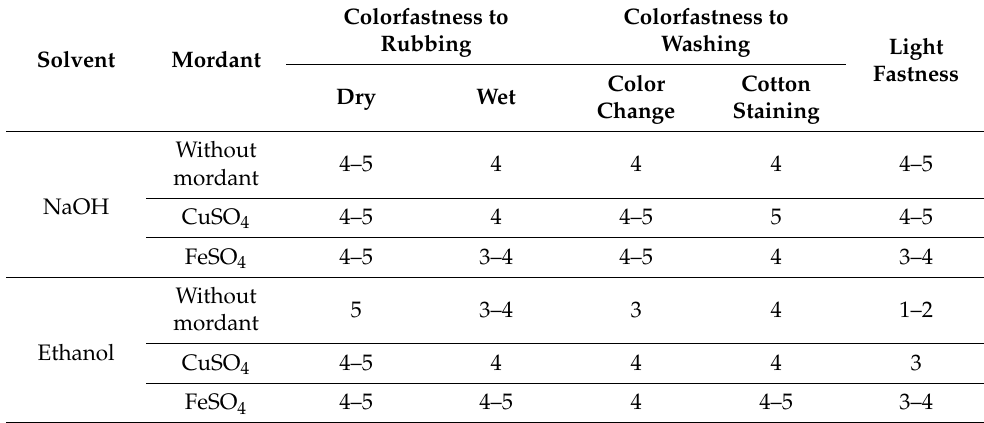
Colorfastness to Rubbing